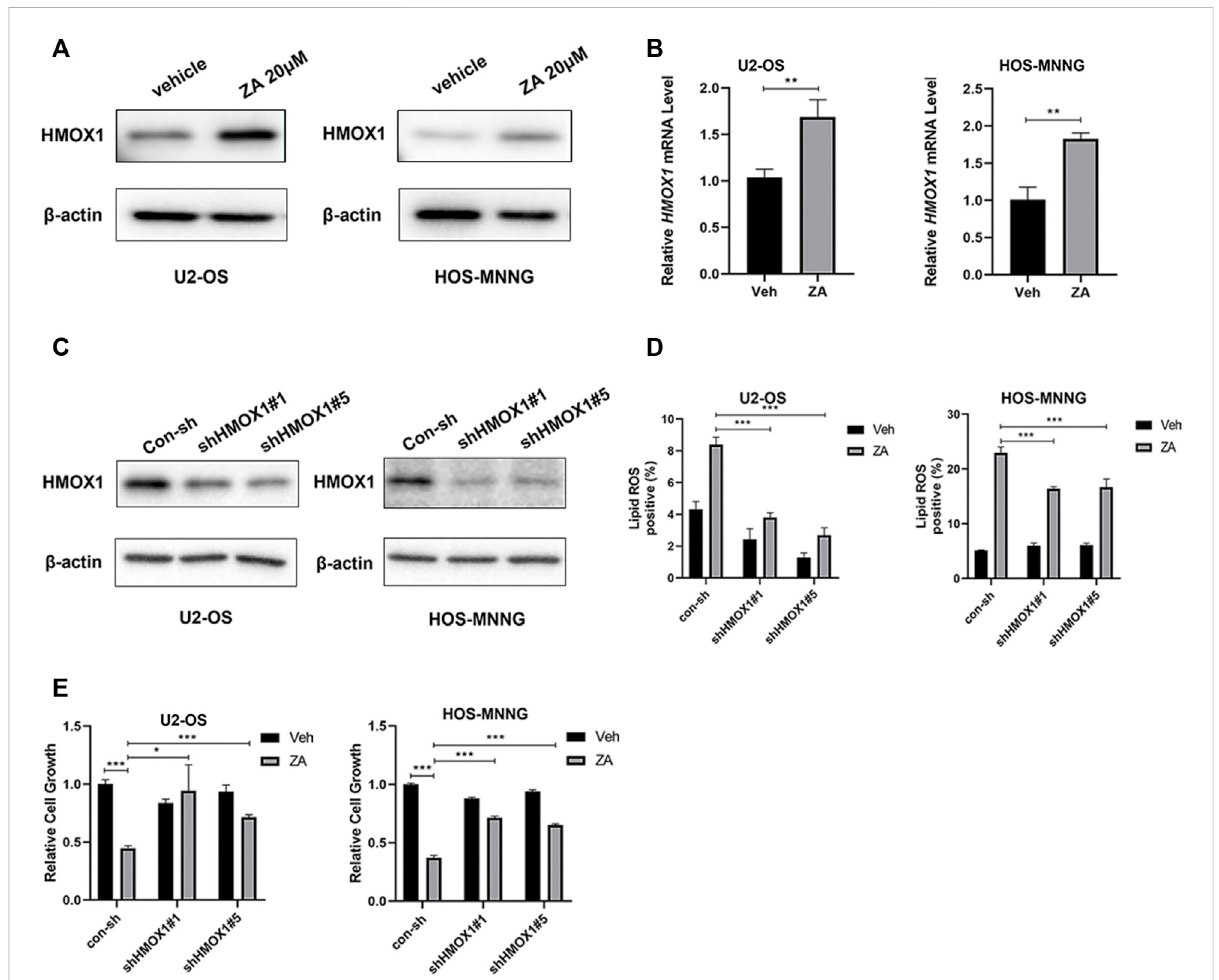
HMOX1 mediates zoledronic acid-induced ferroptosis in osteosarcoma cells (A,B) ZA treatment increases HMOX1 expression. U2-OS and HOS-MNNG cells were treated with vehicle (Veh) and 20 μ M ZA for 24 h. HMOX1 protein levels were detected by western blot analysis (A) and HMOX1 mRNA levels were quanti fi ed by qPCR (B) . (C) HMOX1 protein level was ef fi ciently knocked down by two different shRNAs in U2-OS and HOS-MNNGcells. (D) KnockdownofHMOX1decreasesZA-inducedincreaseinlipidROSlevel.Indicatedcellsexpressingcontrol-shRNA(con- sh)andtwodifferentHMOX1shRNAs(shHMOX#1andshHMOX#5)weretreatedwithVehand20 μ M ZAfor24 h,andlipidROSlevelswereanalyzed. (E)